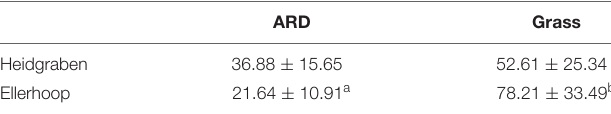
TABLE 3 | Fresh weight of roots after 12 months of growth in ARD or grass plots at Heidgraben and